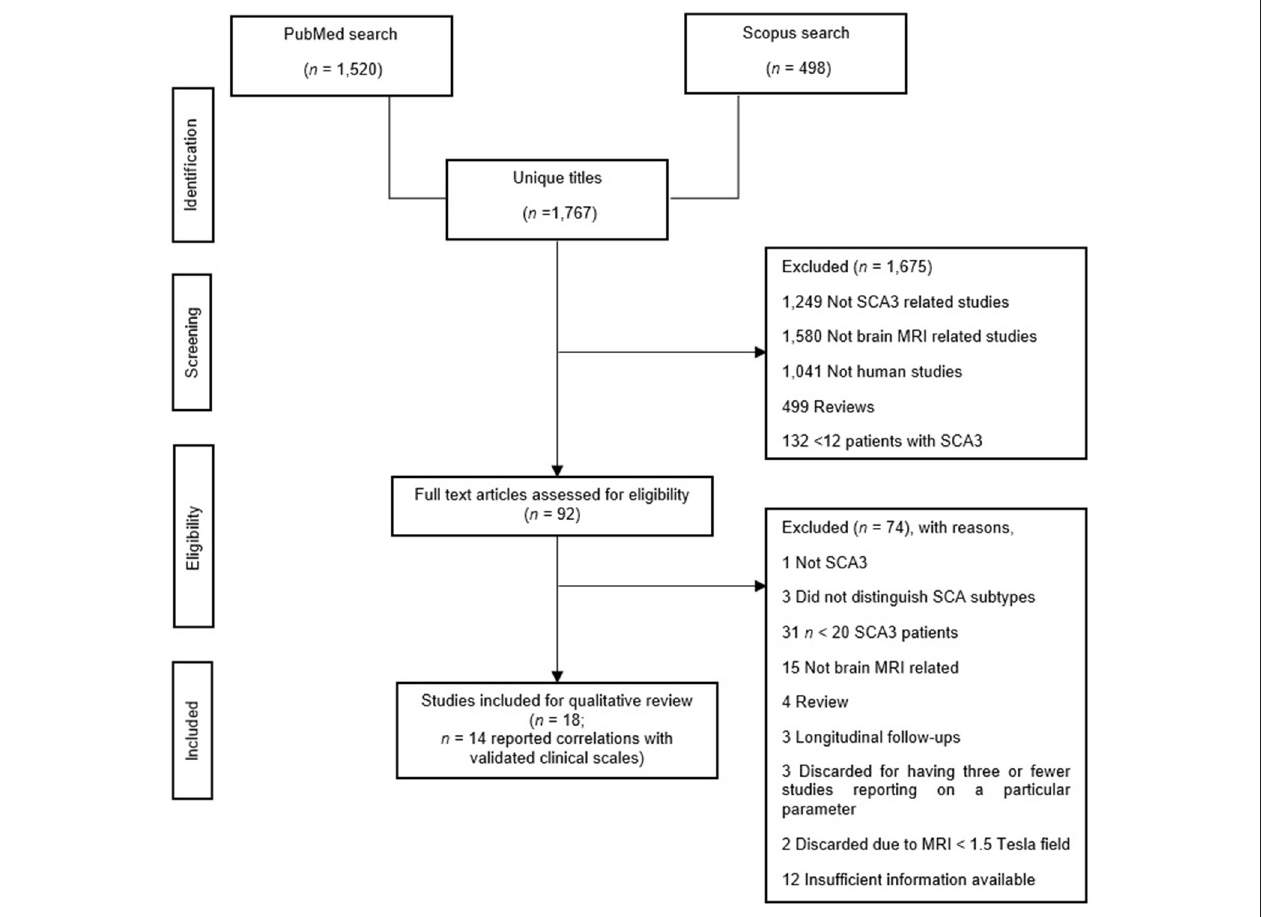
FIGURE 1 | Study search in accordance with the PRISMA guideline (Page et al.,